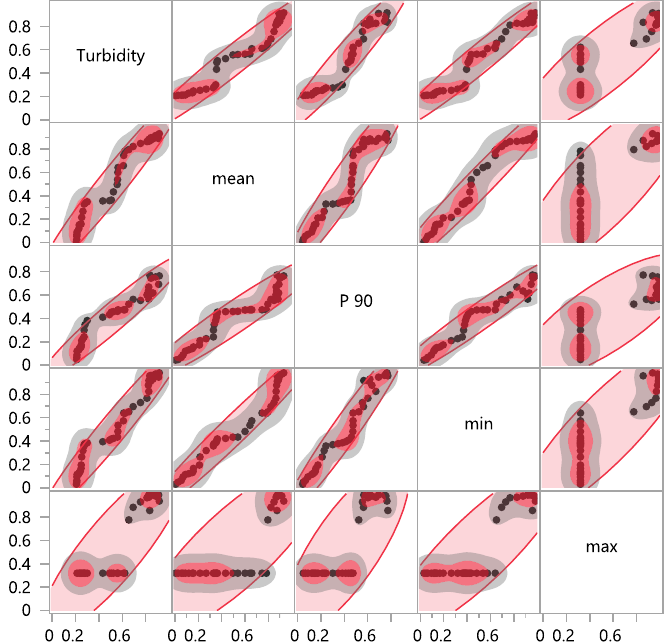
Figure 7. Scatter plot matrix of NDTI—actual and different zonal estimated values. Table 2. The correlation coefficient of the water quality parameters.